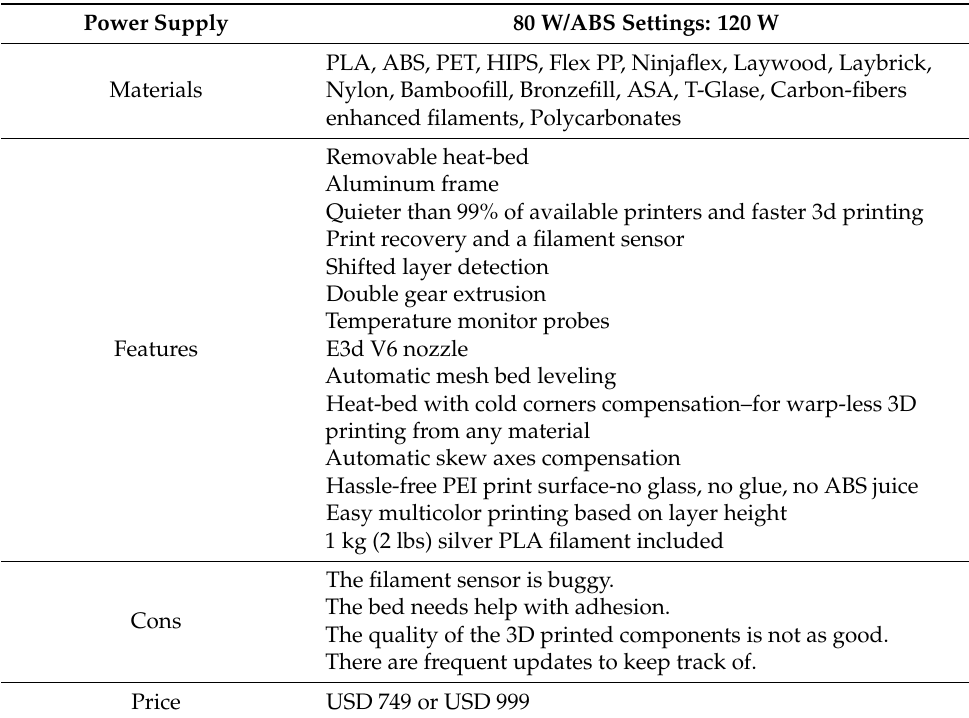
Table 6. Descriptions of Prusa i3 MK3 Desktop 3D Printer.